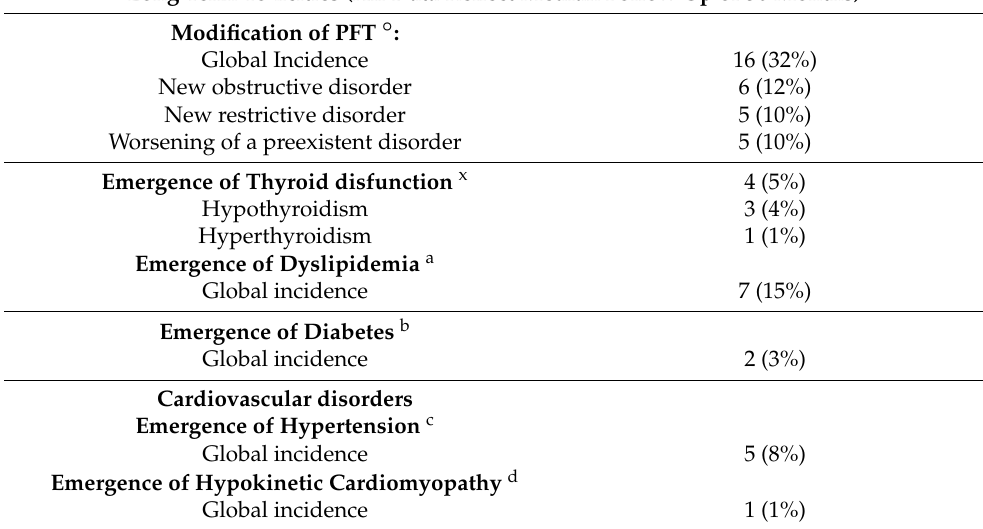
Table 3. Long Term Toxicities. PFT = Pulmonary Function Test; ◦ data were available for 51 patients; x Data were available for 77 patients; a Data were available for 47 patients; b Data were available for 76 patients; c Data were available for 63 patients; d Data were available for 80 patients, defined as ejection fraction <